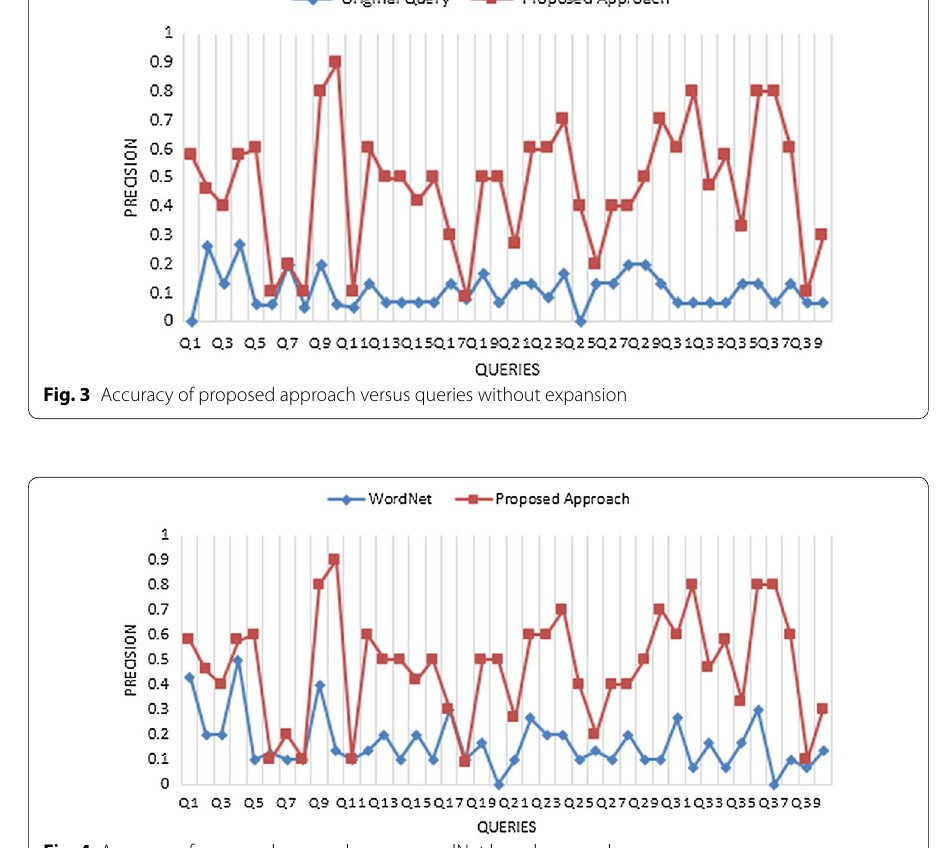
Fig. 4 Accuracy of proposed approach versus wordNet based